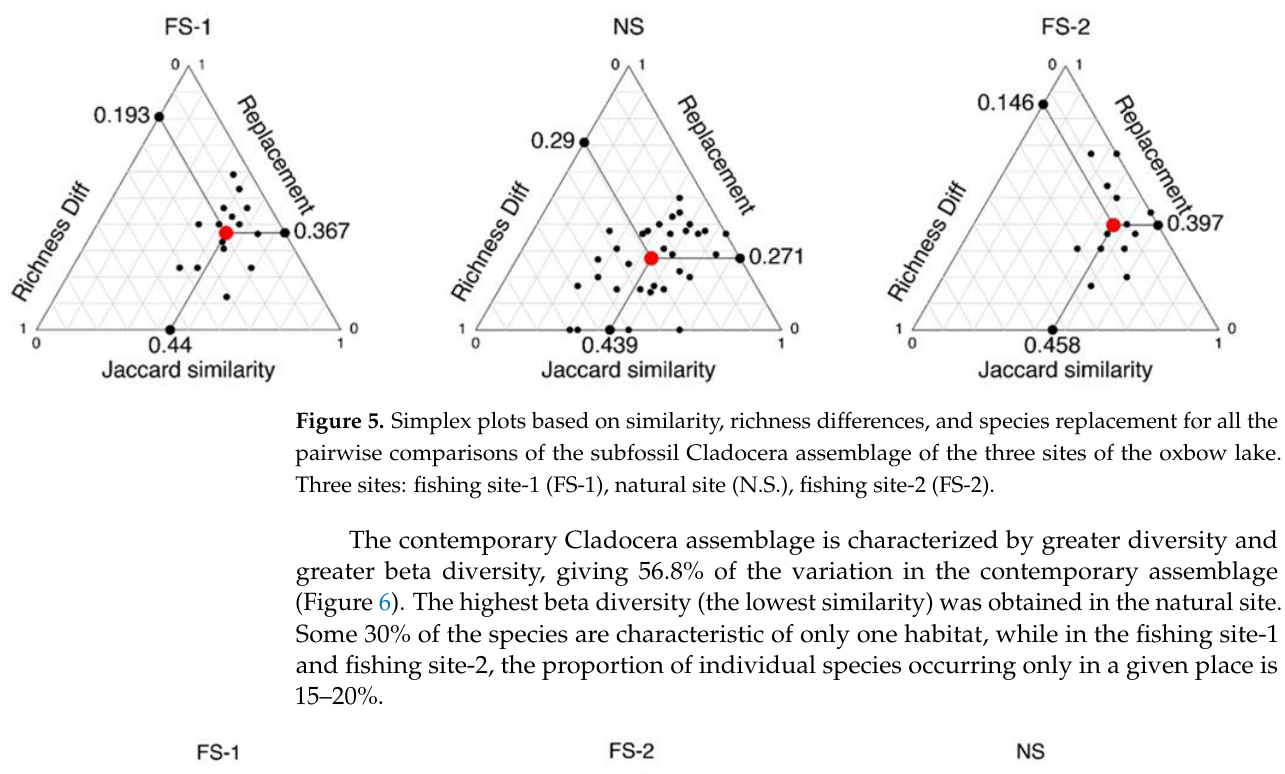
Figure 4. Distance-based redundancy analysis (dbRDA) ordination plot showing ( A ) contemporary and ( B ) subfossil Cladocera assemblages among the three sites concerning forward measured phys- ical – chemical variables; Color of sites represented samples taken from the three different sites (Red color-Fishing site-1, Blue color-Natural site, and Green color-Fishing site − 2).